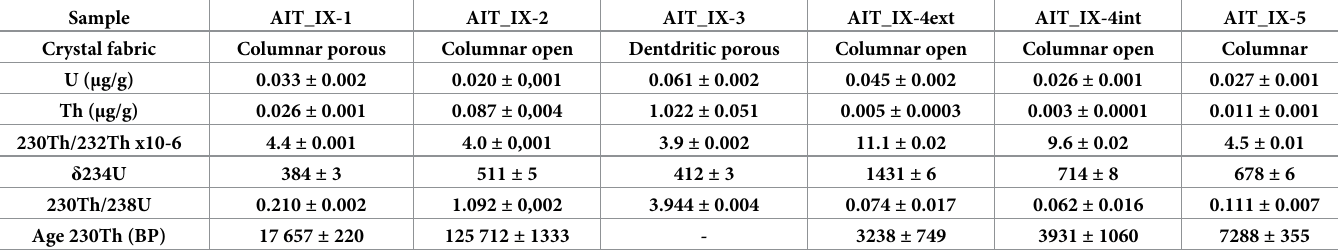
Table 1. Cristal fabric (based on Frisia, 2015) and results of the U/Th dating of speleothem samples from Aitzbitarte IX. Dating performed in CENIEH Uranium Series Laboratory (Spain).